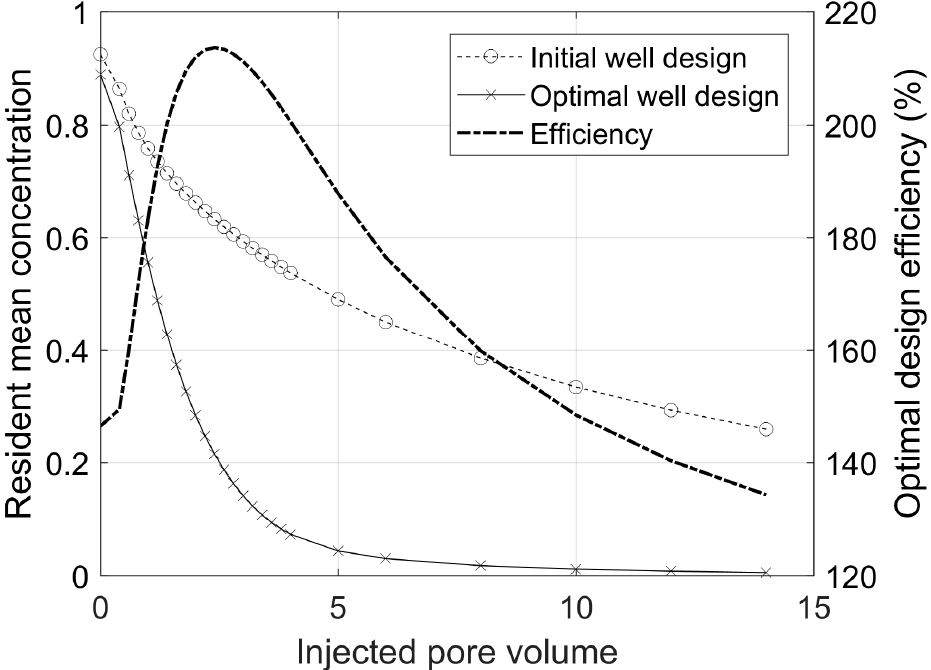
Figure 10. Evolution of the resident mean concentration and the P&T system efficiency versus injected pore volumes for the initial and optimal P&T designs in the two-dimensional heterogeneous aquifer.